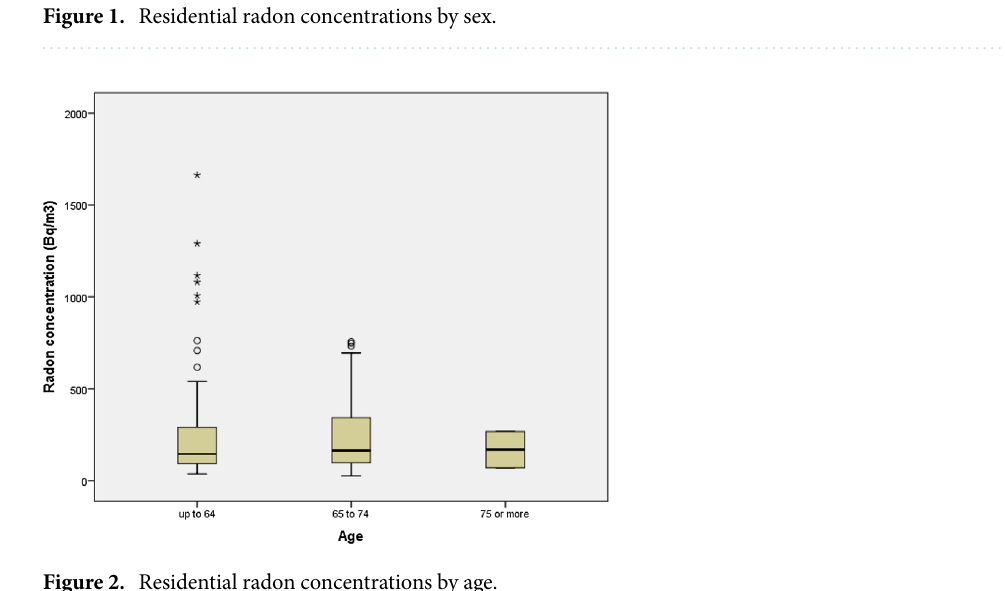
Figure 1. Residential radon concentrations by sex.